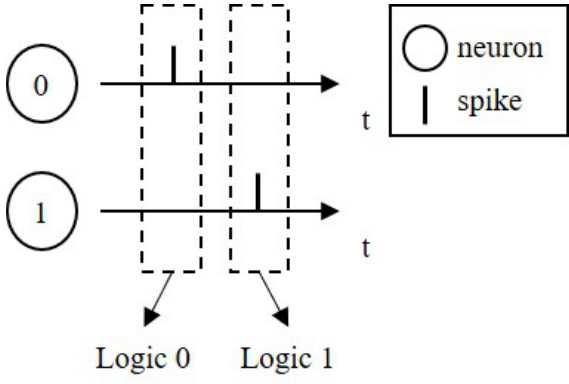
Figure 1. Definition and encoding of logical variables in